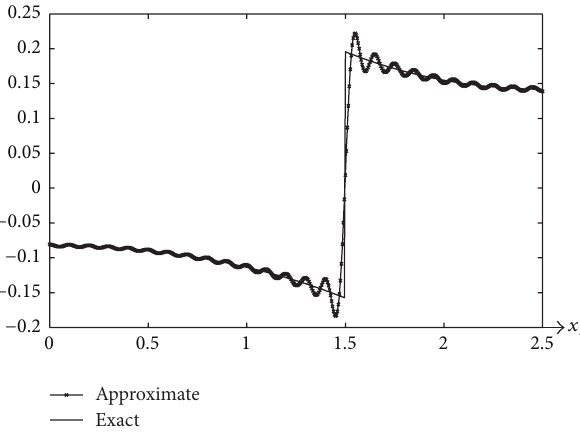
Figure 2: The graphs of ℎ 1 2 and ℎ 1,𝑁 2 for 𝑁 = 50 , 𝑥 0 1 = 2 , 𝑥 0 2 = 3 , and = 1.5 𝑥 0 3